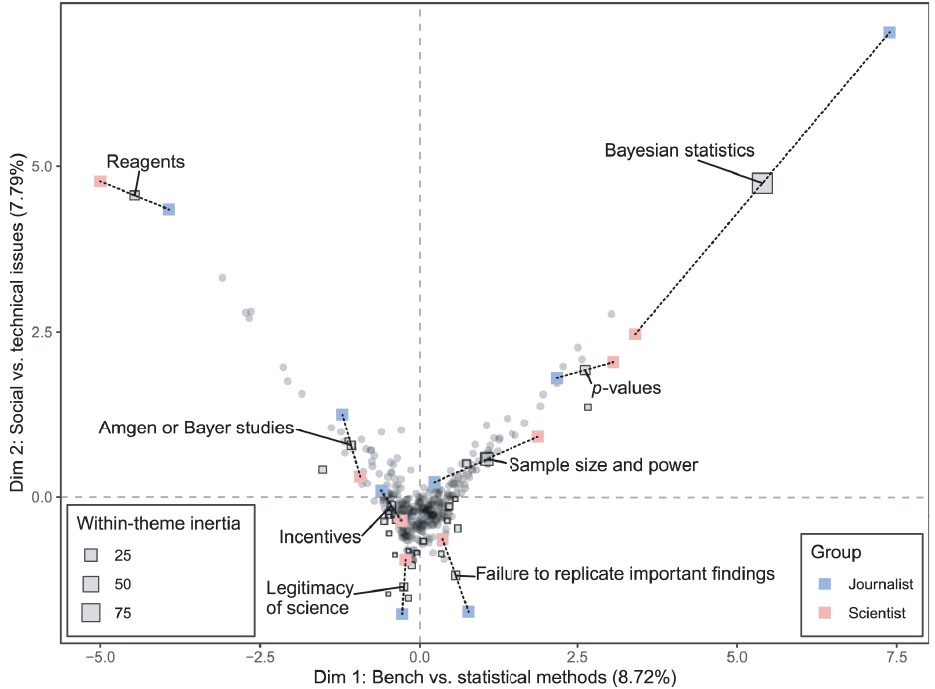
Fig 6. Multiple factor analysis of 353 articles discussing reproducibility, analyzed for 29 themes, with articles grouped by author type. The size of the square indicates the degree of within-theme inertia. The eight themes with the greatest within-theme inertia are labeled, and partial points for those themes are displayed. Red points indicate the location of those themes in the group of articles authored by scientists, and blue points indicate the theme location for the journalist group. Grey points indicate the location of the articles on the first factor